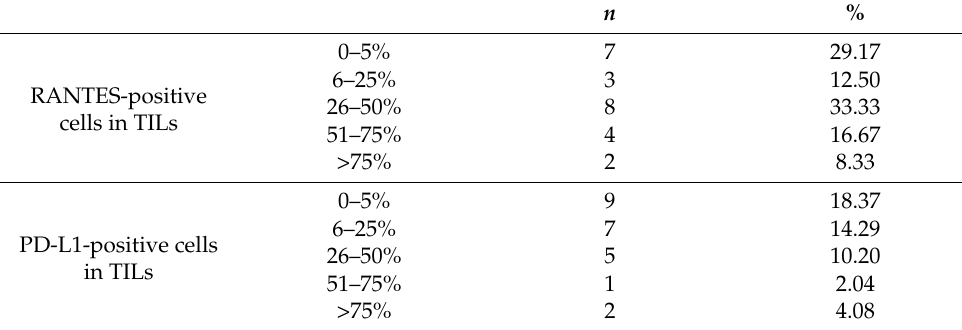
Table 12. Assessment of RANTES and PD-L1 expression in